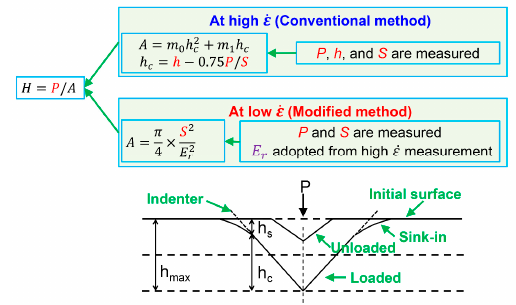
Figure 2. Flowcharts illustrating differences between conventional and modified methods. The conventional method measures h , P , and S at different strain rates ( (cid:2013)(cid:4662) ). Values of h c , A , E r , H , and E can be derived. The modified method first determines E r at high (cid:2013)(cid:4662) , then applies E r as a known parameter at lower (cid:2013)(cid:4662) . The h and A value at low (cid:2013)(cid:4662) can be calculated instead of directly measured to reduce the thermal-drift effects.